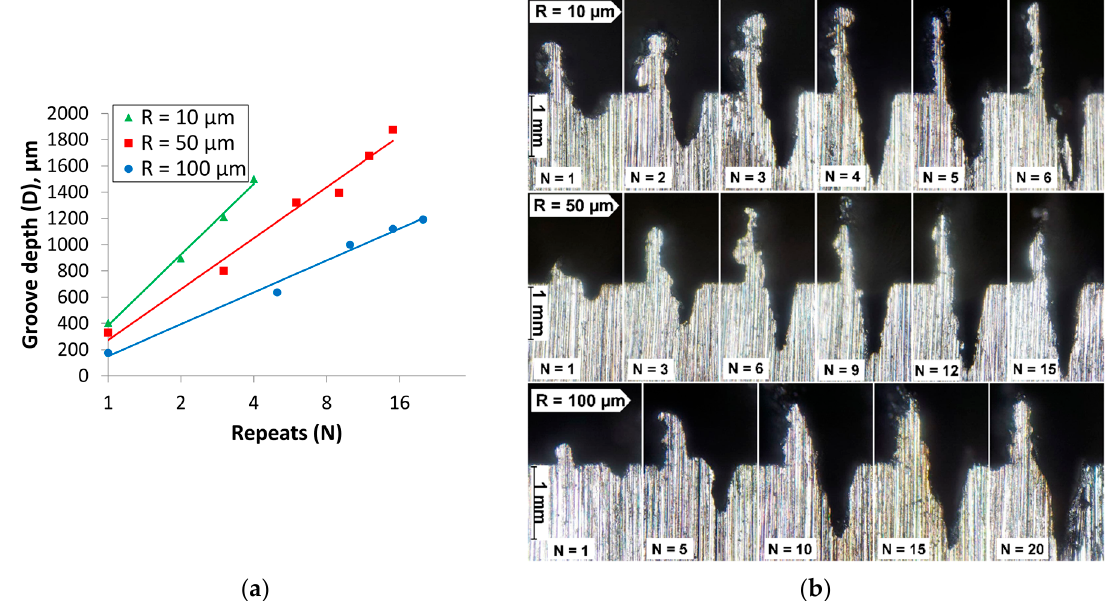
Figure 9. ( a ) Graph of the dependences of the groove depth ( D ) on the number of passes ( N ), with different distances between the vectors ( R ), as well as ( b ) the transverse sections of the grooves obtained.